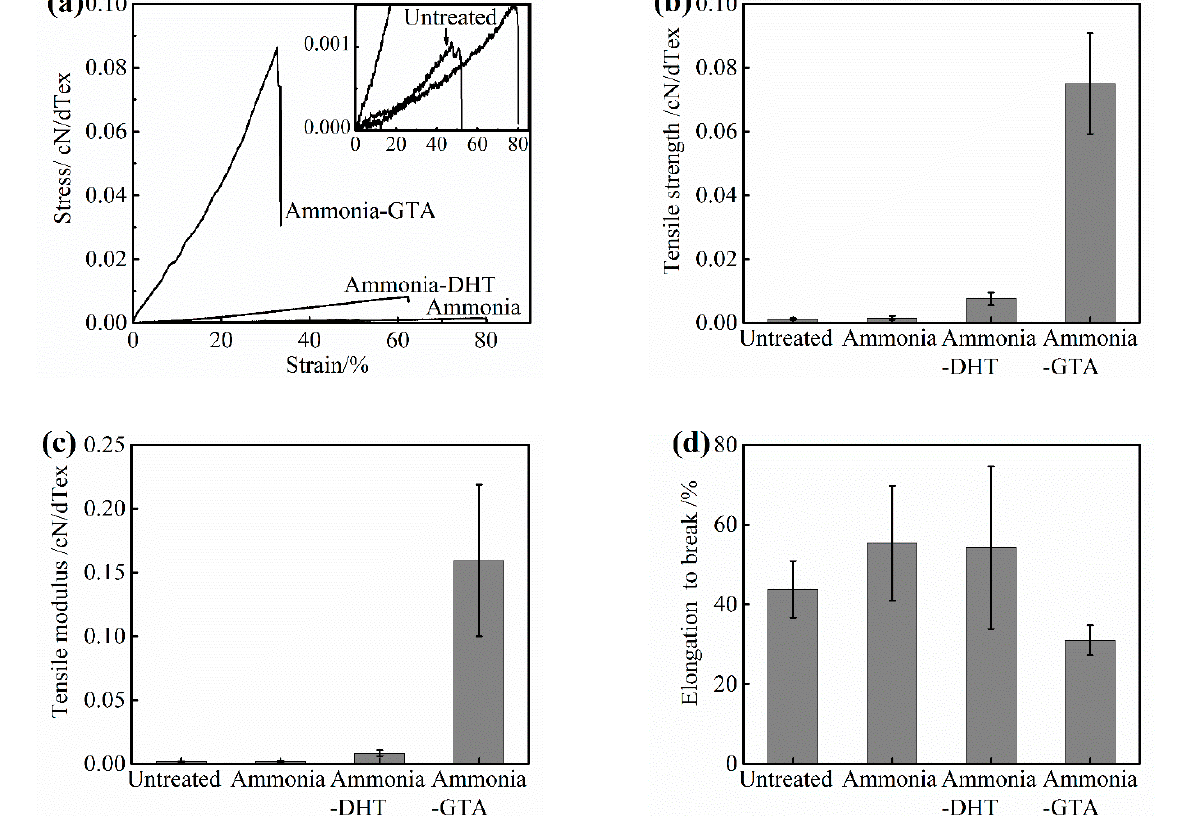
Figure 9. Mechanical properties of collagen tubes before and after various treatments in a wet state: ( a ) stress-strain curves, ( b ) tensile strength, ( c ) tensile modulus and ( d ) elongation to break.